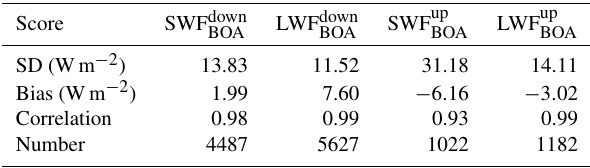
Table 7. Validation results for monthly Cloud_cci AVHRR-PMv3 shortwave and longwave and downwelling and upwelling radia- tive fluxes at bottom of atmosphere (BOA) when compared with Baseline Surface Radiation Network (BSRN) sites within the pe- riod 2003–2016. Validation measures are standard deviation (SD), bias and correlation. In addition the number of data pairs is